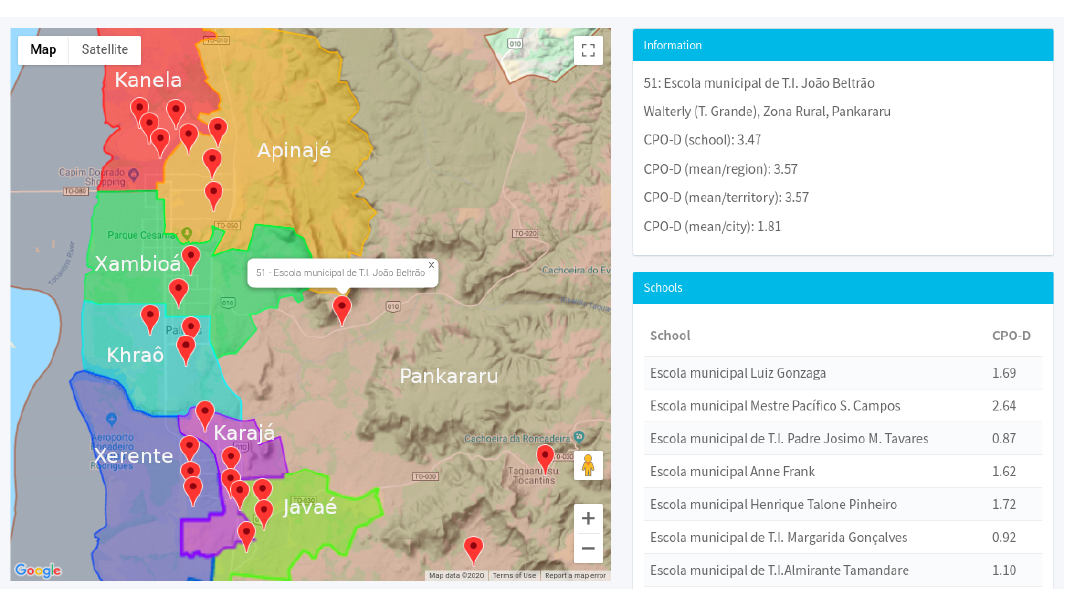
Figure 8. Geographic map of the location of schools in health territories with the respective calculated CPO-d. Source: Figure elaborated by the own